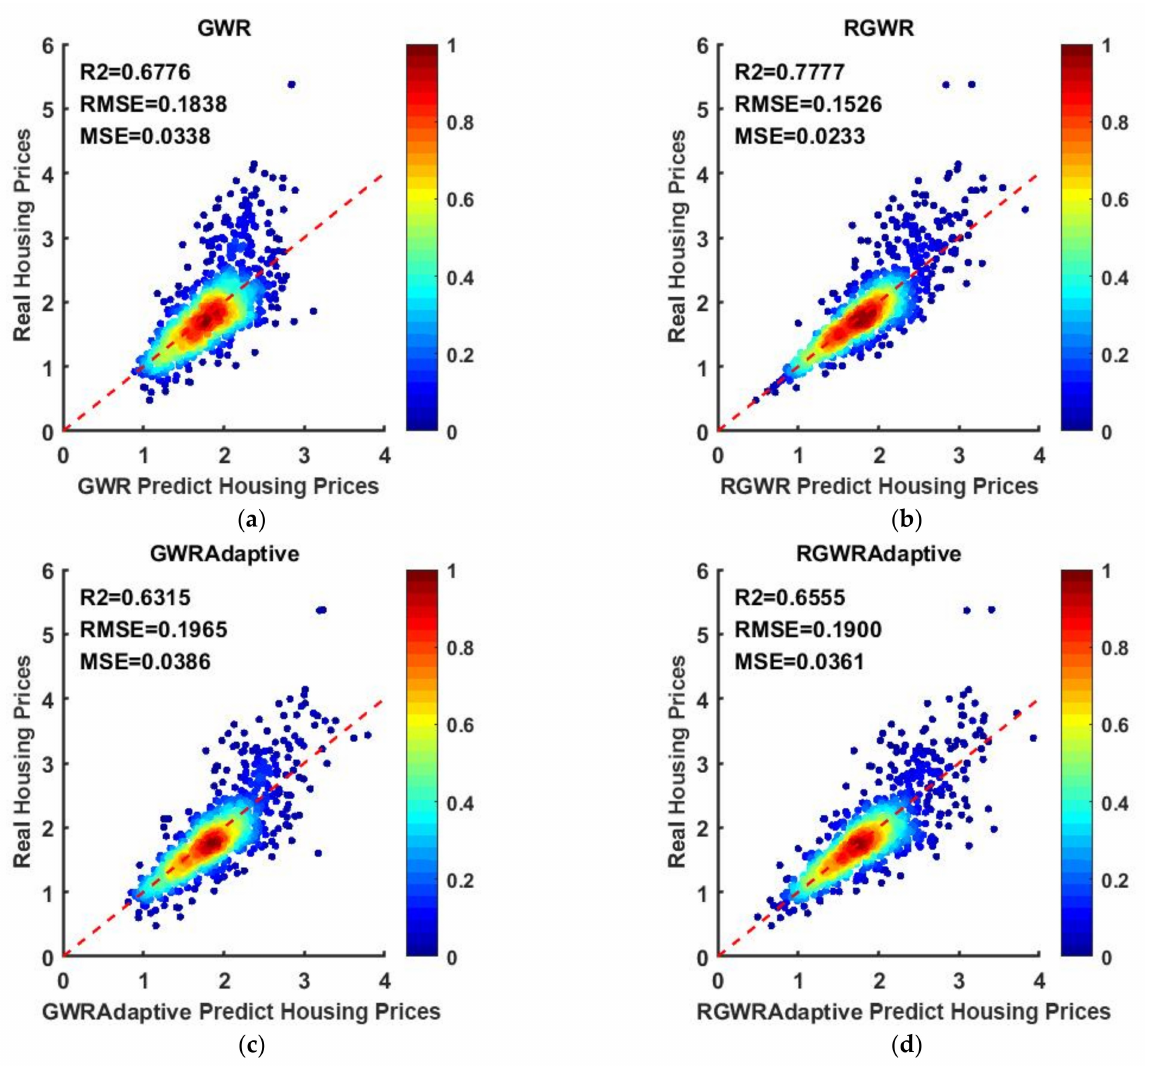
Figure 4. Fitting effect distribution of GWR and RGWR. ( a ) Predicted value and the real value of the housing prices in the GWR models under the fixed bandwidth strategies; ( b ) Predicted value and the real value of the housing prices in the RGWR models under the fixed bandwidth strategies; ( c ) Predicted value and the real value of the housing prices in the GWR models under the adaptive bandwidth strategies; ( d ) Predicted value and the real value of the housing prices in the RGWR models under the adaptive bandwidth